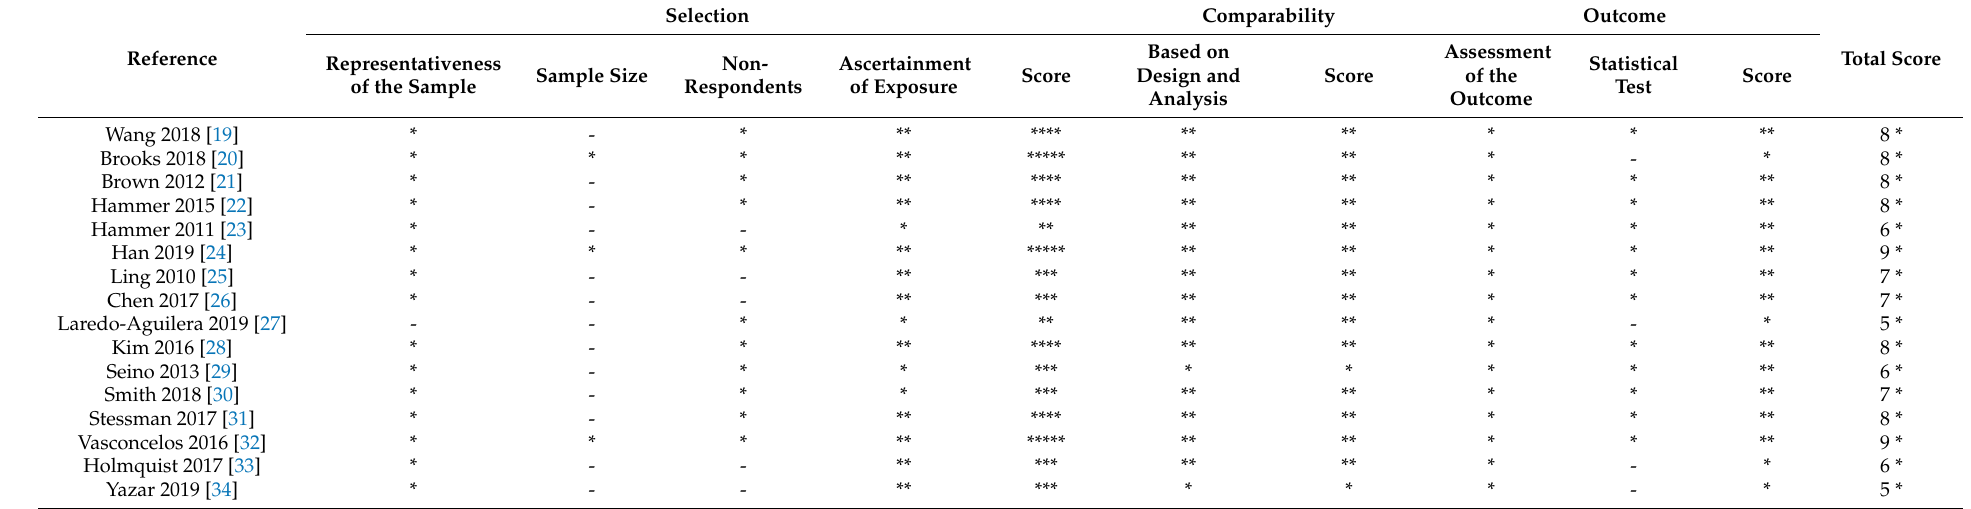
Table 1. Evaluation of the methodological quality of each study using the Newcastle–Ottawa Scale.